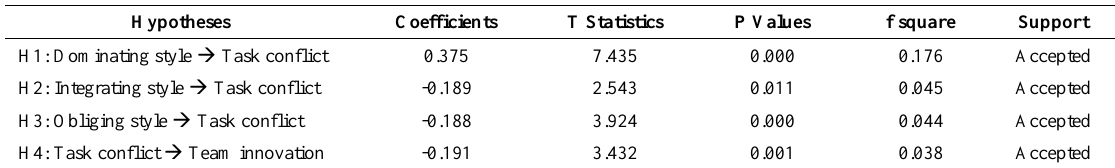
Table 5. Results of a structural equation